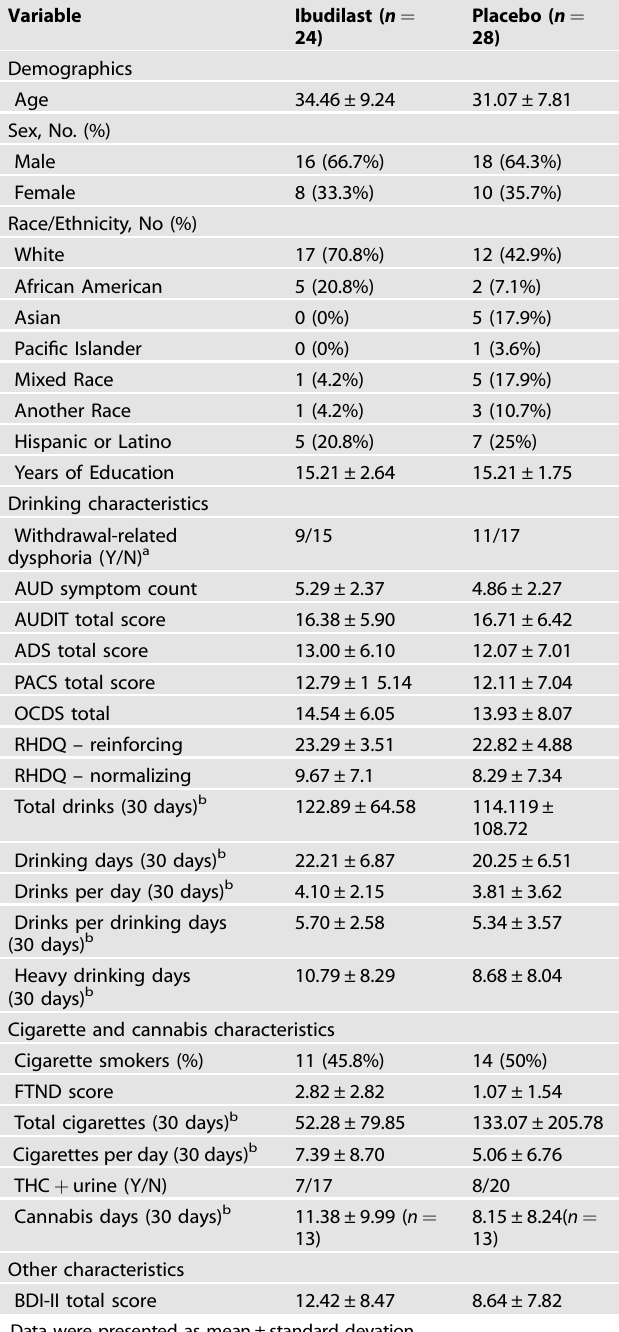
Table 1. Sample characteristics at baseline by treatment